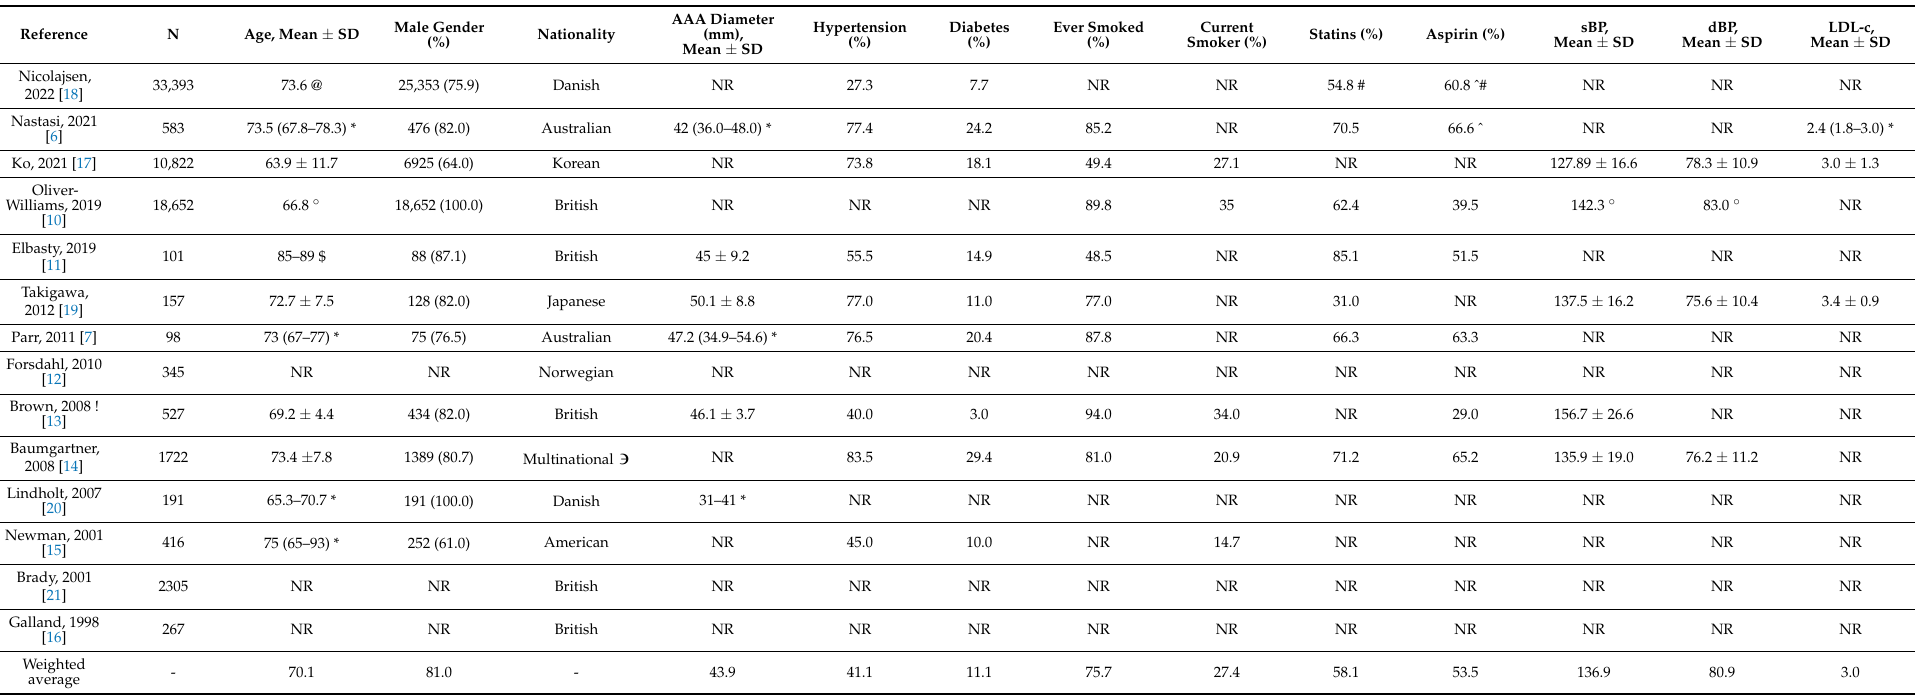
Table 1. Characteristics of included studies and